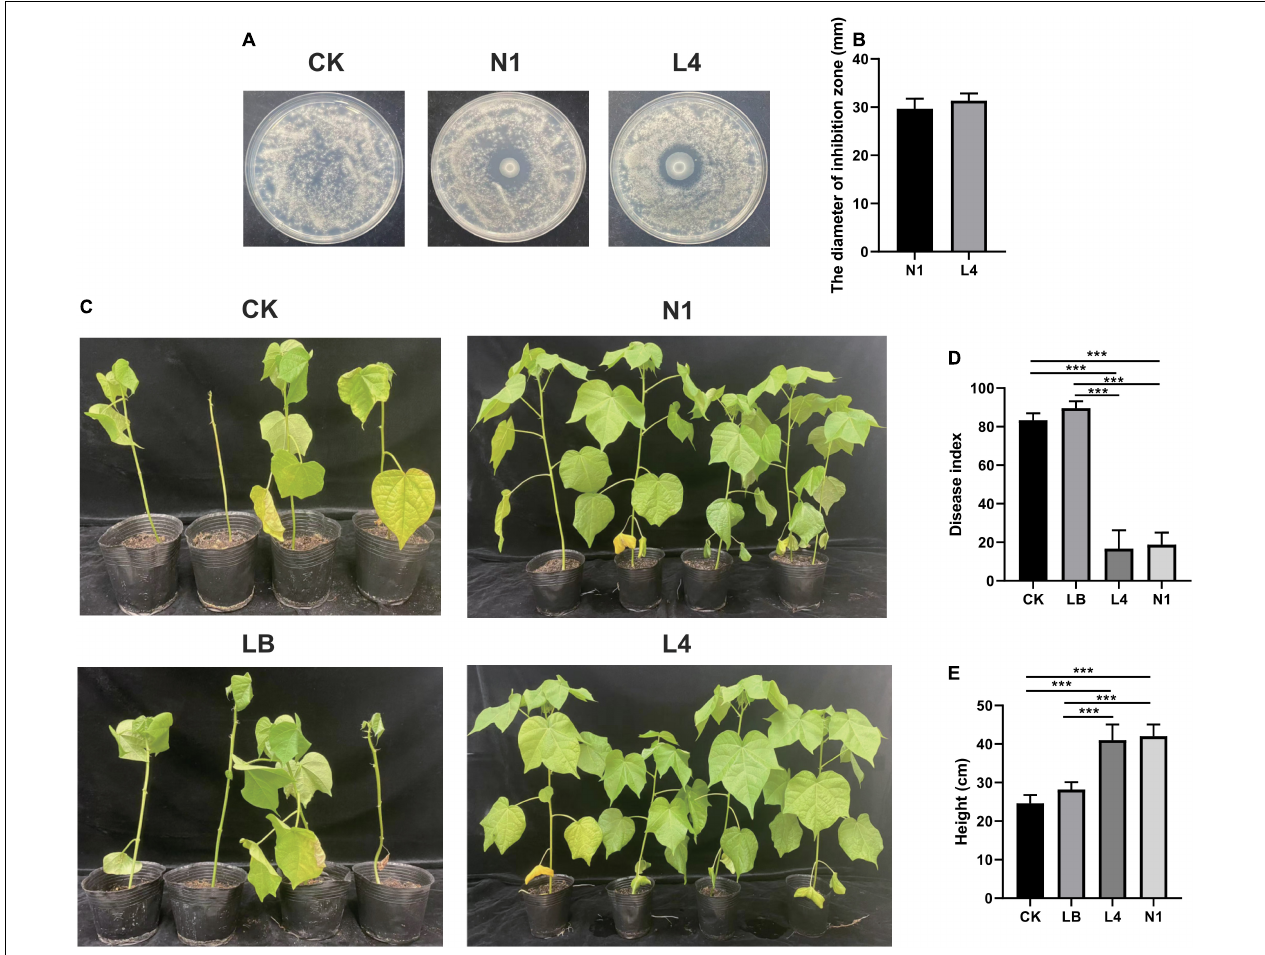
FIGURE 5 | Effect of Pseudomonas sp. on the cotton wilt disease. (A) Effect of single bacterial strain (N1 and L4) on the Verticillium wilt of cotton. (B) Diameter of inhibition zone of single bacteria strain (N1 and L4). Error bars indicate ± SD of three replicates. (C) The phenotypes of cotton inoculated with single bacteria after 40 days of growth in a growth chamber. Effect of the single bacteria (N1 and L4) on the disease index (D) and the height of cotton plants (E) . *** Represents obvious differences at P < 0.001 compared with the